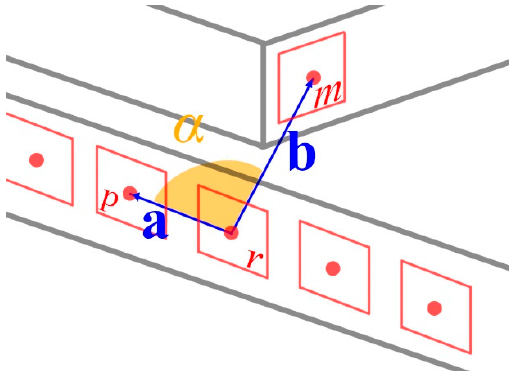
Figure 4. Orientation invariance of the macro-feature description vector. The images show the relative distances and orientation of a few selected macro-features, with 'e' being the microfeature of which the description vector is being calculated. Image ( a ) shows the macro-features in the 3D CAD model while image ( b ) shows the same macro-features in the SLAM map.